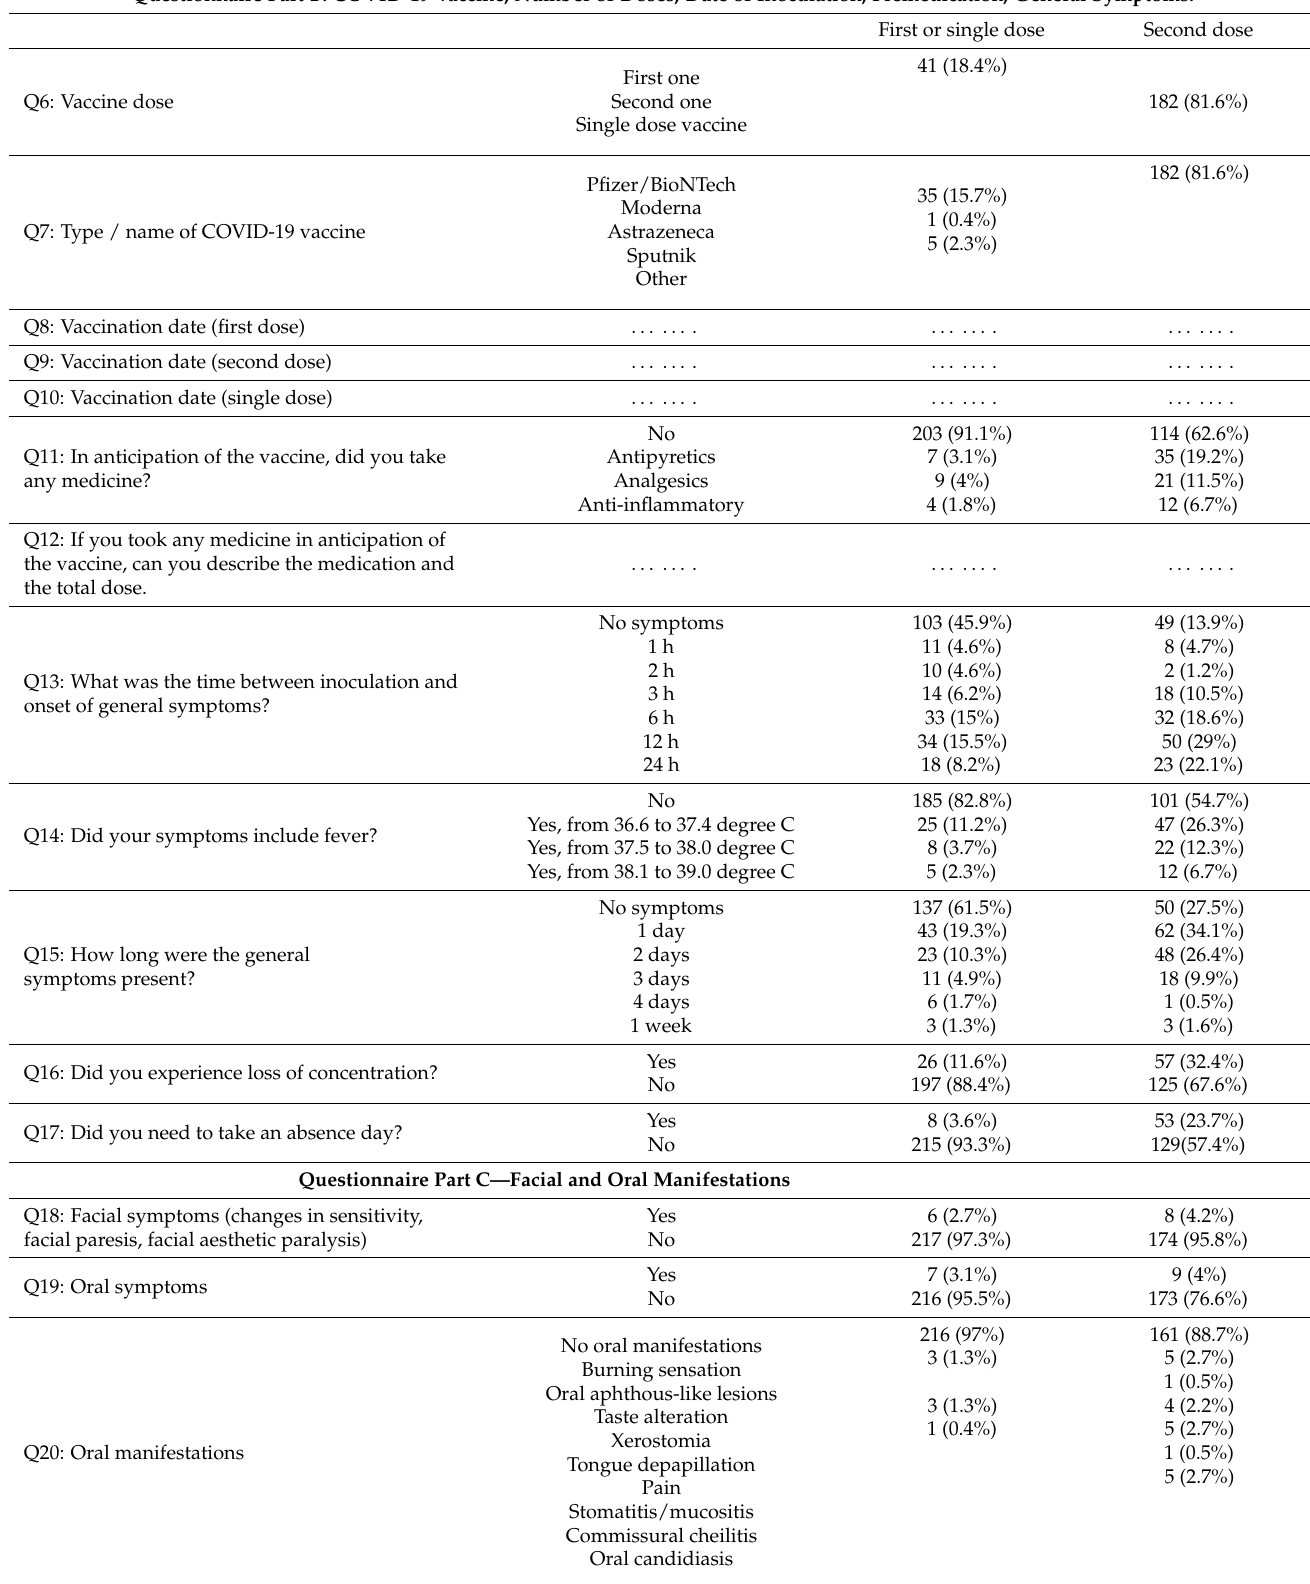
Table 2. The answers given by the